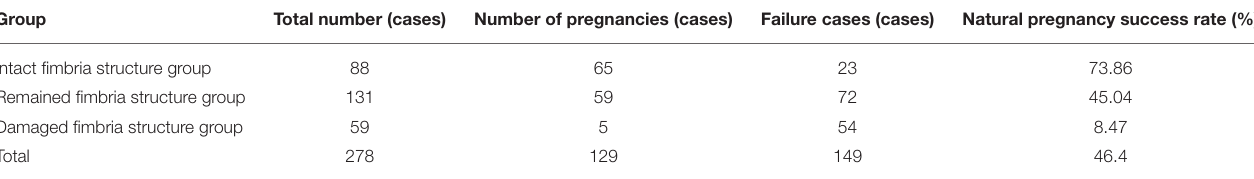
TABLE 4 | Fallopian tube fimbria structure and post-operative pregnancy outcome. Group Total number